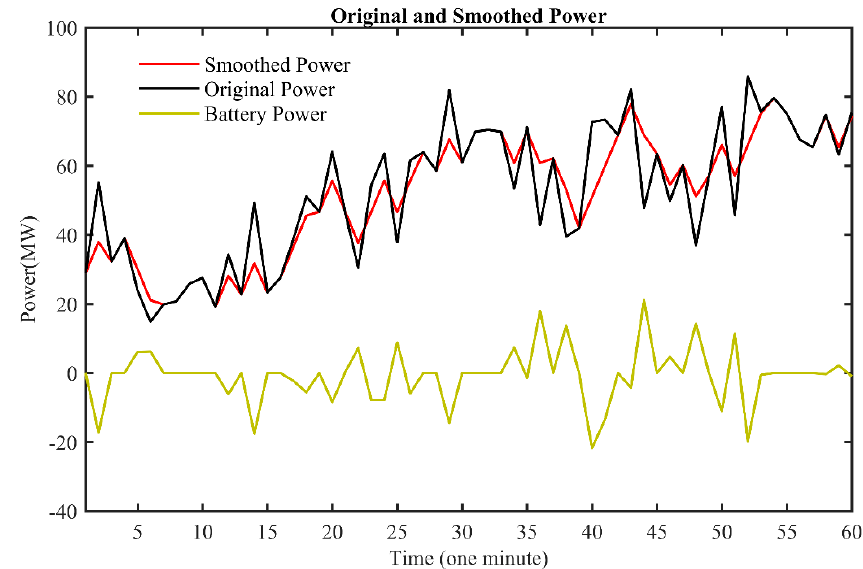
Figure 4. Sample DST-based battery power